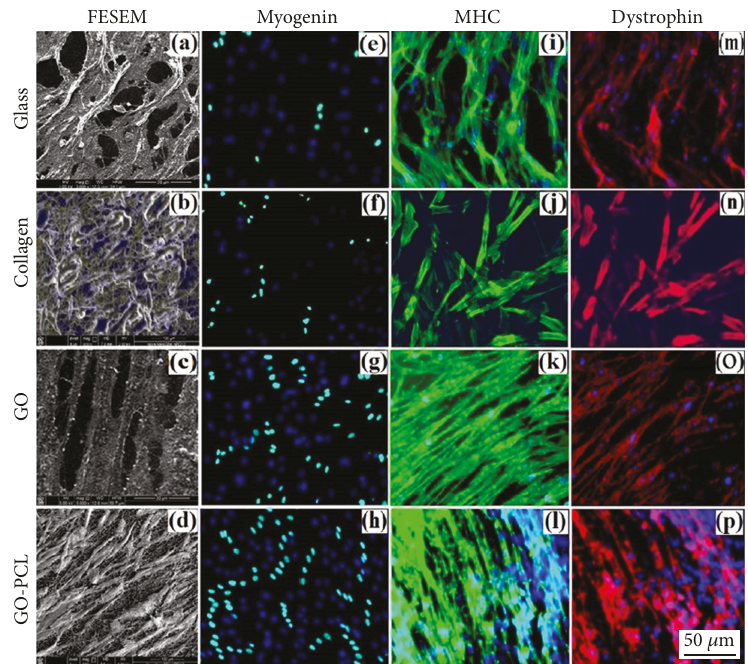
Figure 9: FESEM micrographs showing formation of myotubes on glass and collagen controls (a and b), GO sheets (c), and GO-PCL meshes (d). Expression of the early myogenic di ff erentiation marker myogenin-positive nuclei (green) on controls (e and f), GO sheets (g), and GO-PCL meshes (h). Immunostaining of MHC (green), respectively, on controls (i and j), GO sheets (k), and GO-PCL meshes (l) and dystrophin (red) similarly on controls (m and n), GO sheets (o), and GO-PCL meshes (p). Nuclei were counterstained with DAPI